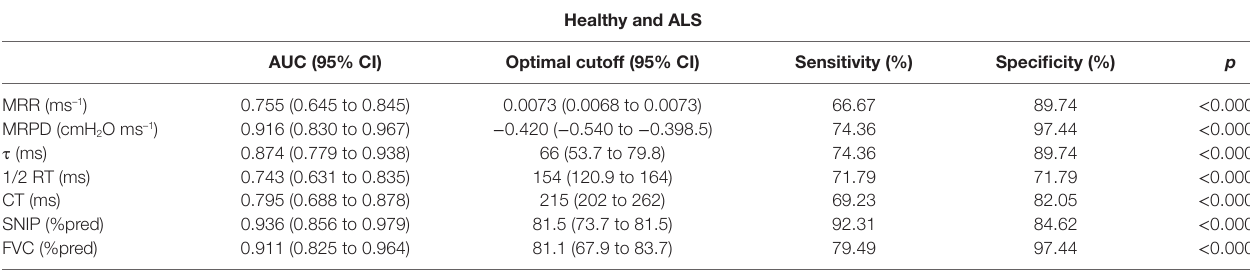
AUC, area under curve; CI, confidence interval; MRR, maximum relaxation rate; MRPD, maximum rate of pressure development; τ , tau; 1/2RT, half-relaxation time; CT, contraction time; SNIP, sniff nasal inspiratory pressure; FVC, forced vital capacity; ES, effect size; %pred, percentage of predicted; cmH 2 O, centimeter of water; ALS, amyotrophic lateral sclerosis.